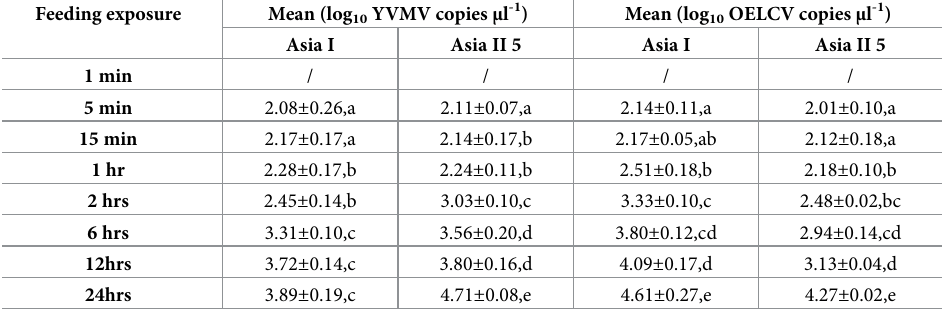
OELCuV than Asia II 5. The viral load reached its highest level after 24 hrs of feeding in case of Asia I genetic group, with 4.61 copies per microliter, i.e. 1.07-fold higher as compared with